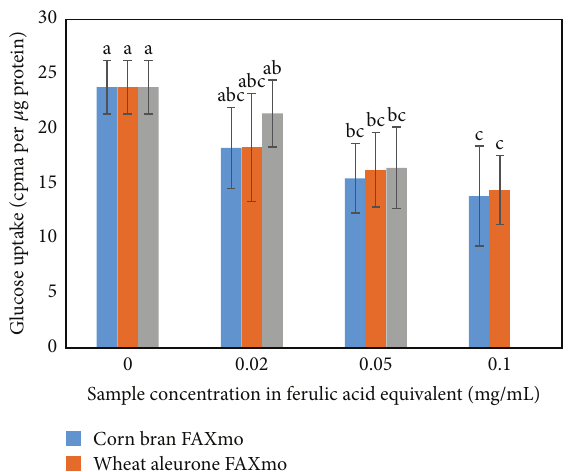
Figure 5: Effect of ferulic acid and feruloylated arabinoxylan mono- and oligosaccharides extracts on glucose uptake in Caco- 2 cells in sodium-free medium. Values are presented as mean ± standard deviation ( 𝑛 = 6). Data with the same superscript are not significantly different at 𝑝 ≤ 0.05 . FAXmo means feruloylated arabinoxylan mono- and oligosaccharide extract.